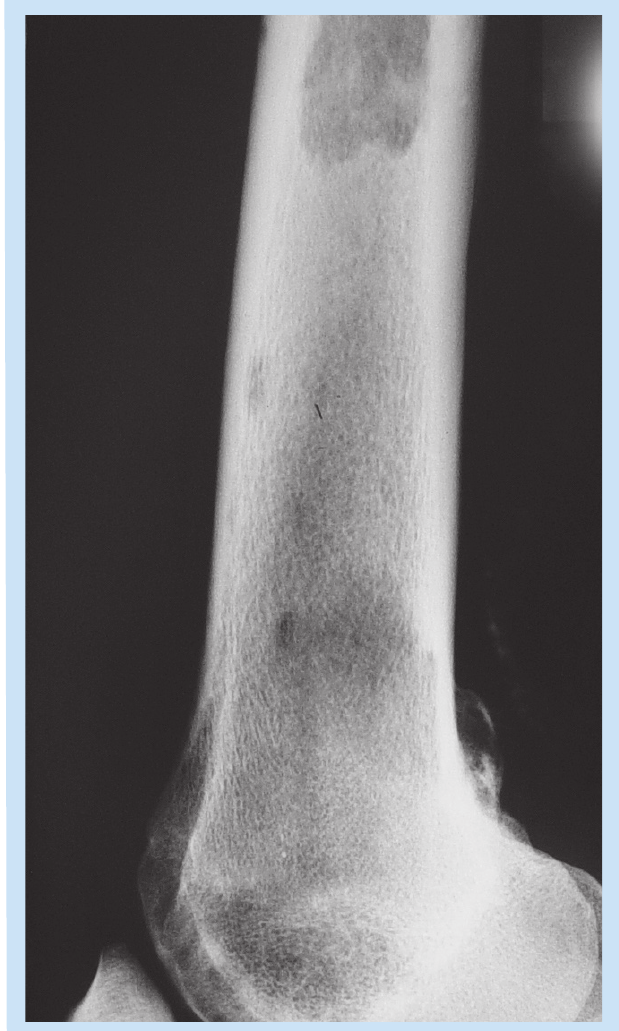
Figs. 1a - d. Conventional X-rays of the right knee, femur and pelvis. Multiple lytic lesions, some well circumscribed and others permeative, in the right tibia, femur and